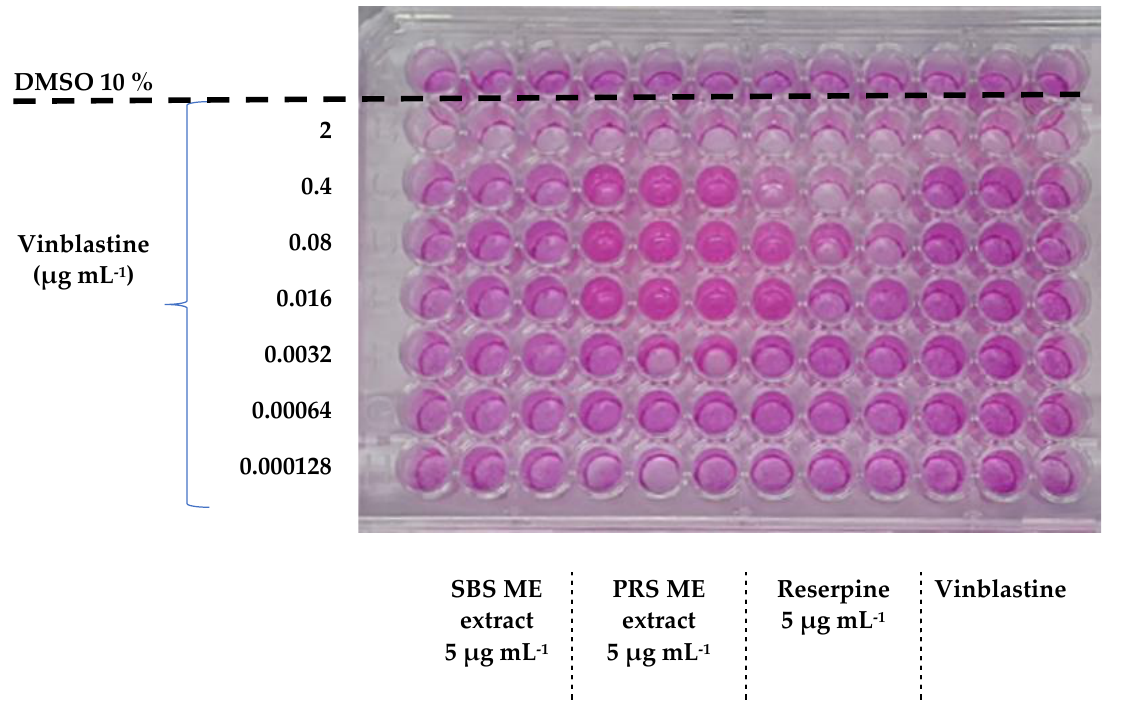
Figure 4. Modulation assay of vinblastine with stems of plants grown on black soil and peduncles of plants grown on red soil extracts obtained using maceration against MCF – 7/Vin + -resistant cell line. SBS ME: extract with the highest reversal factor against MCF – 7/Vin + (RF = 7.78).